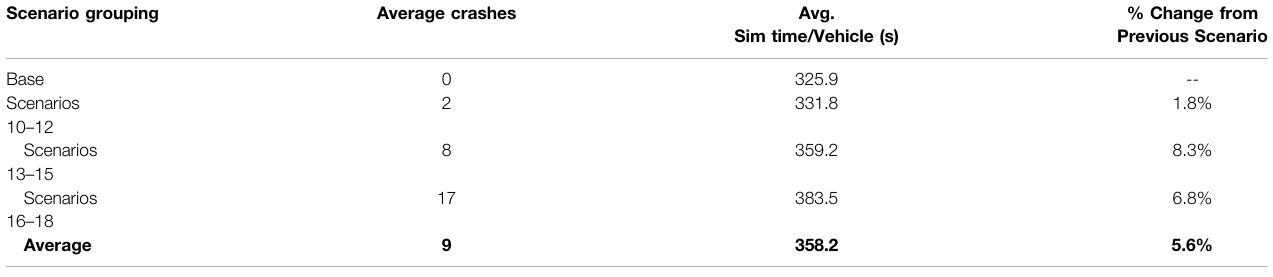
TABLE 7 | MITM results compared by scenario group.